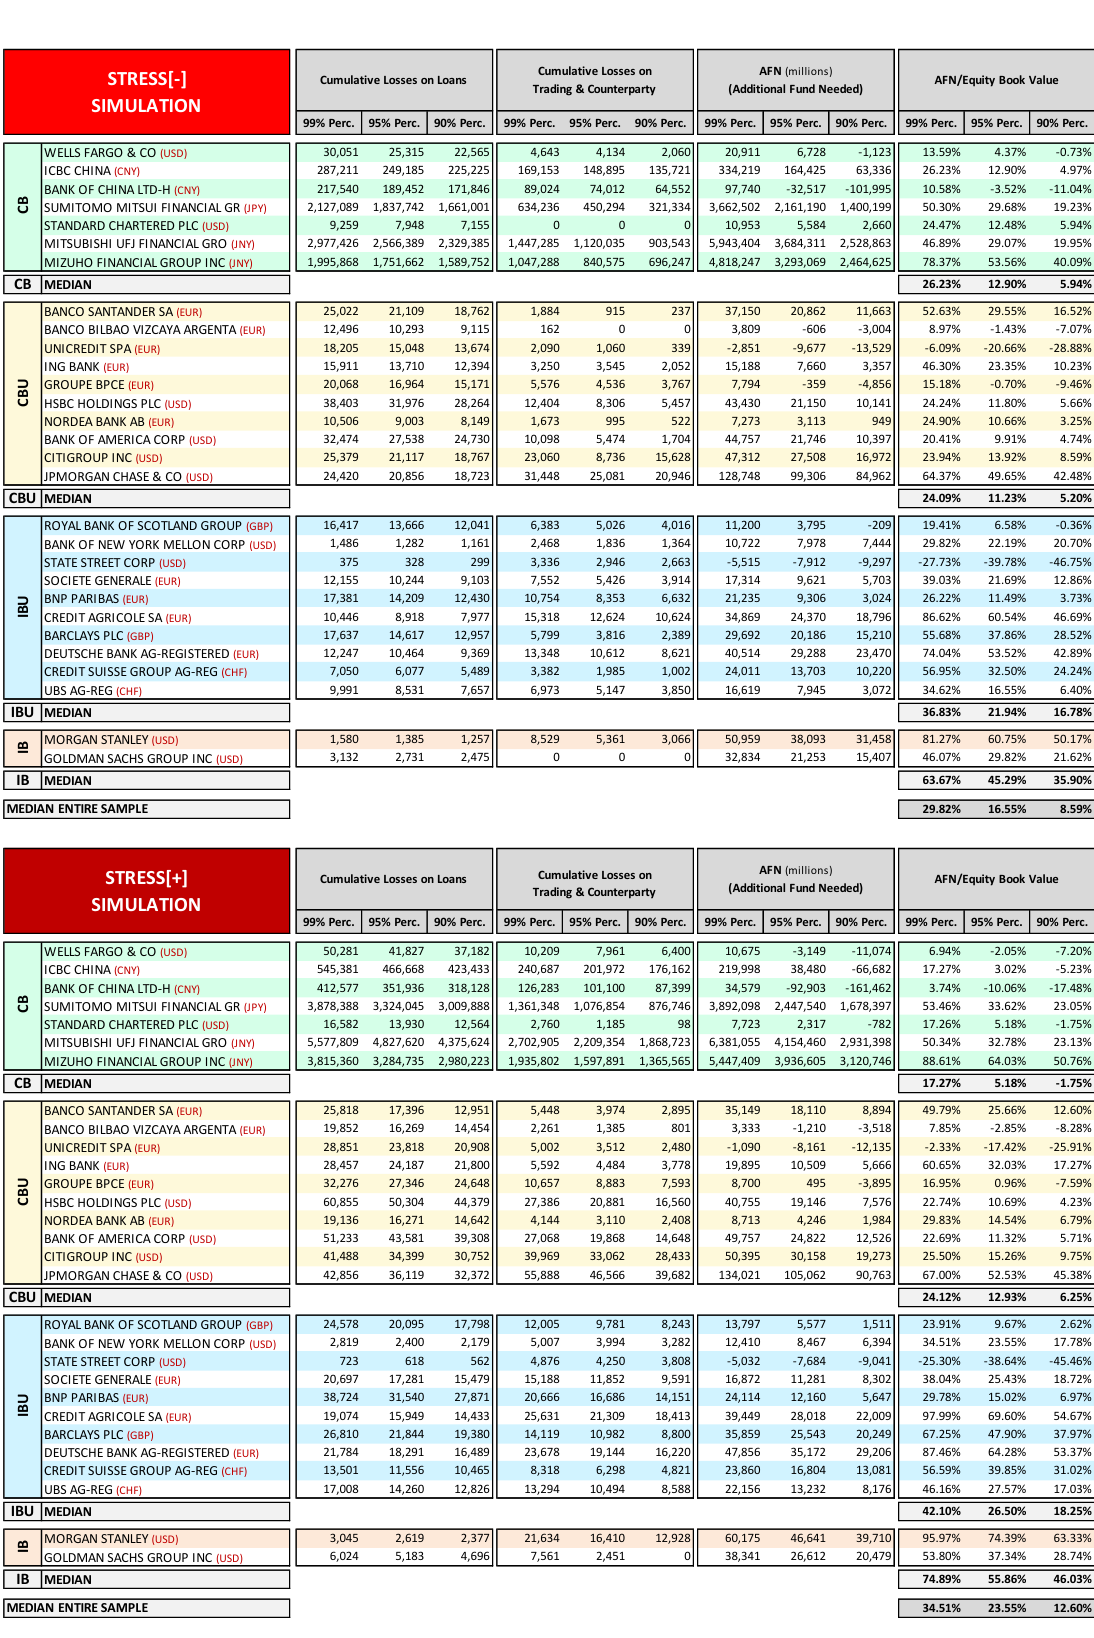
Figure A8. 2015 Stress test exercise: credit/market cumulative losses and funding shortfall.